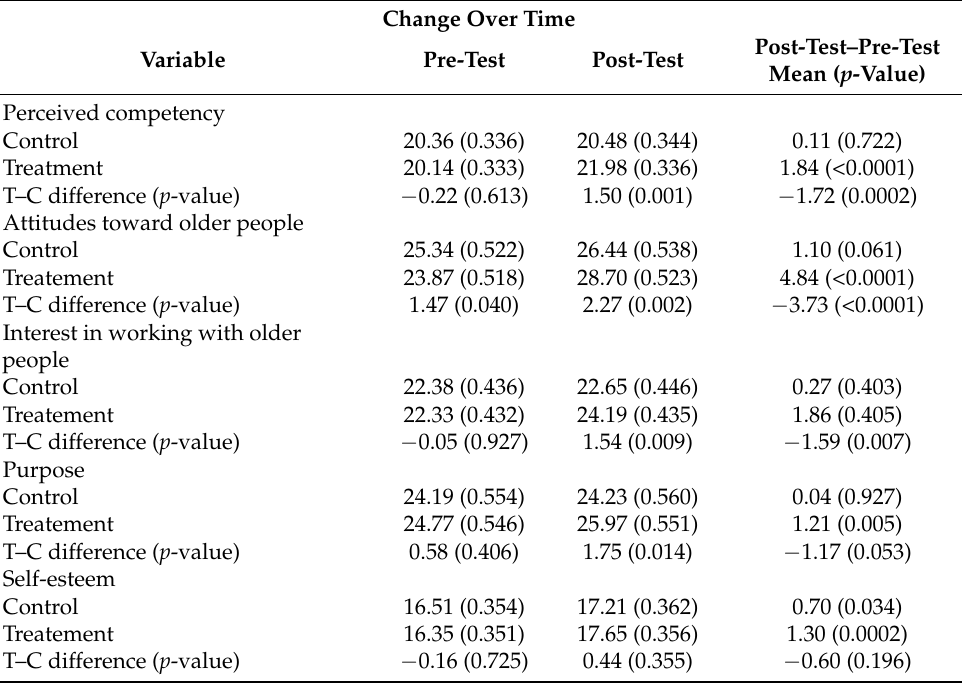
Note: Table entries are means (SEs) in the 2 × 2 (treatment × time) upper left quadrant for each dependent variable and mean differences (Ps) in the other three quadrants. The entries in the bottom right cell for each dependent variable represent the tests of treatment effects. The model for each outcome also includes gender and grade level (middle school-aged versus high school-aged students) as additional fixed classification factors, and individuals as levels of a random classification